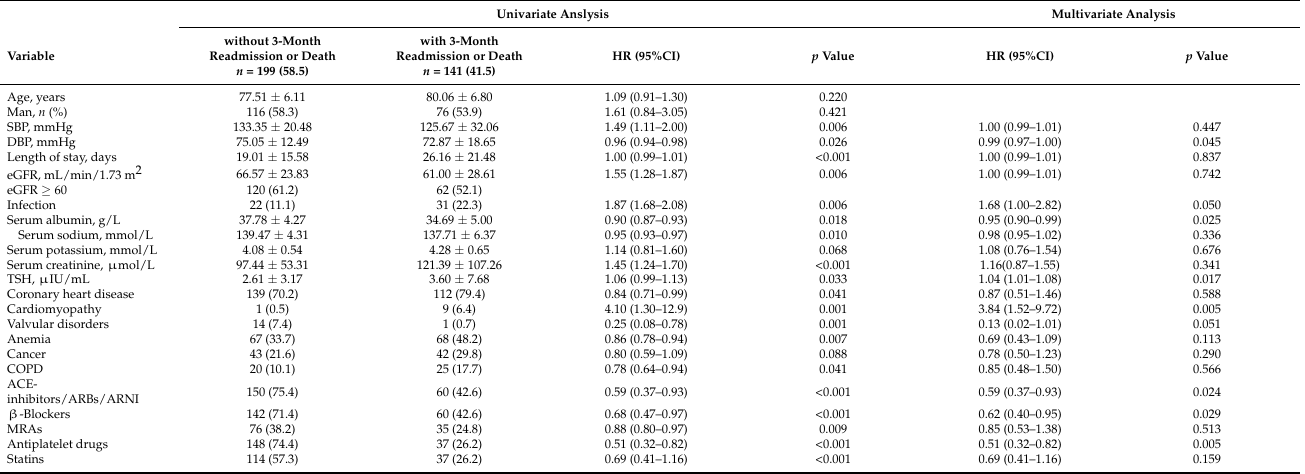
Table 3. Patient characteristics and multivariate analysis of factors for 3-month all-cause readmis- sion or death in elderly HF patients with a history of ischemic stroke.